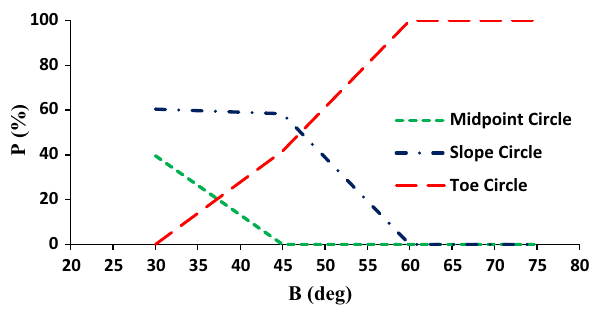
Fig. 5 Factor of safety change ( F 2 , � = 14 ◦ ,18 ◦ ,22 ◦ ( C = 15kN/m